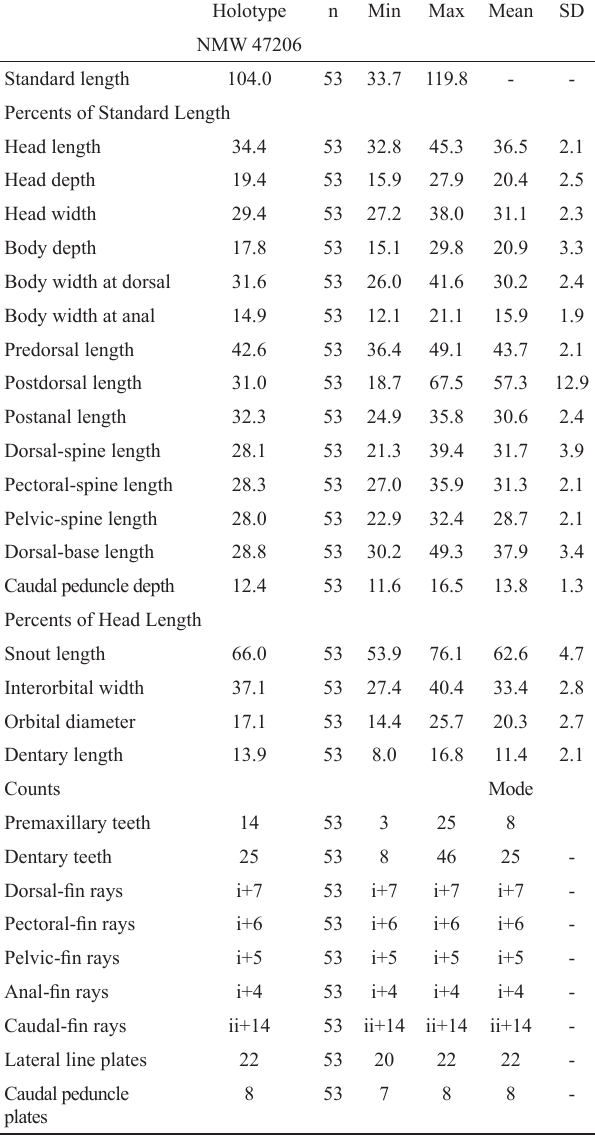
Table 2. Morphometric and meristic data of Spectracanthicus punctatissimus . Values are given as percents of standard length or head length. SD = standard deviation.